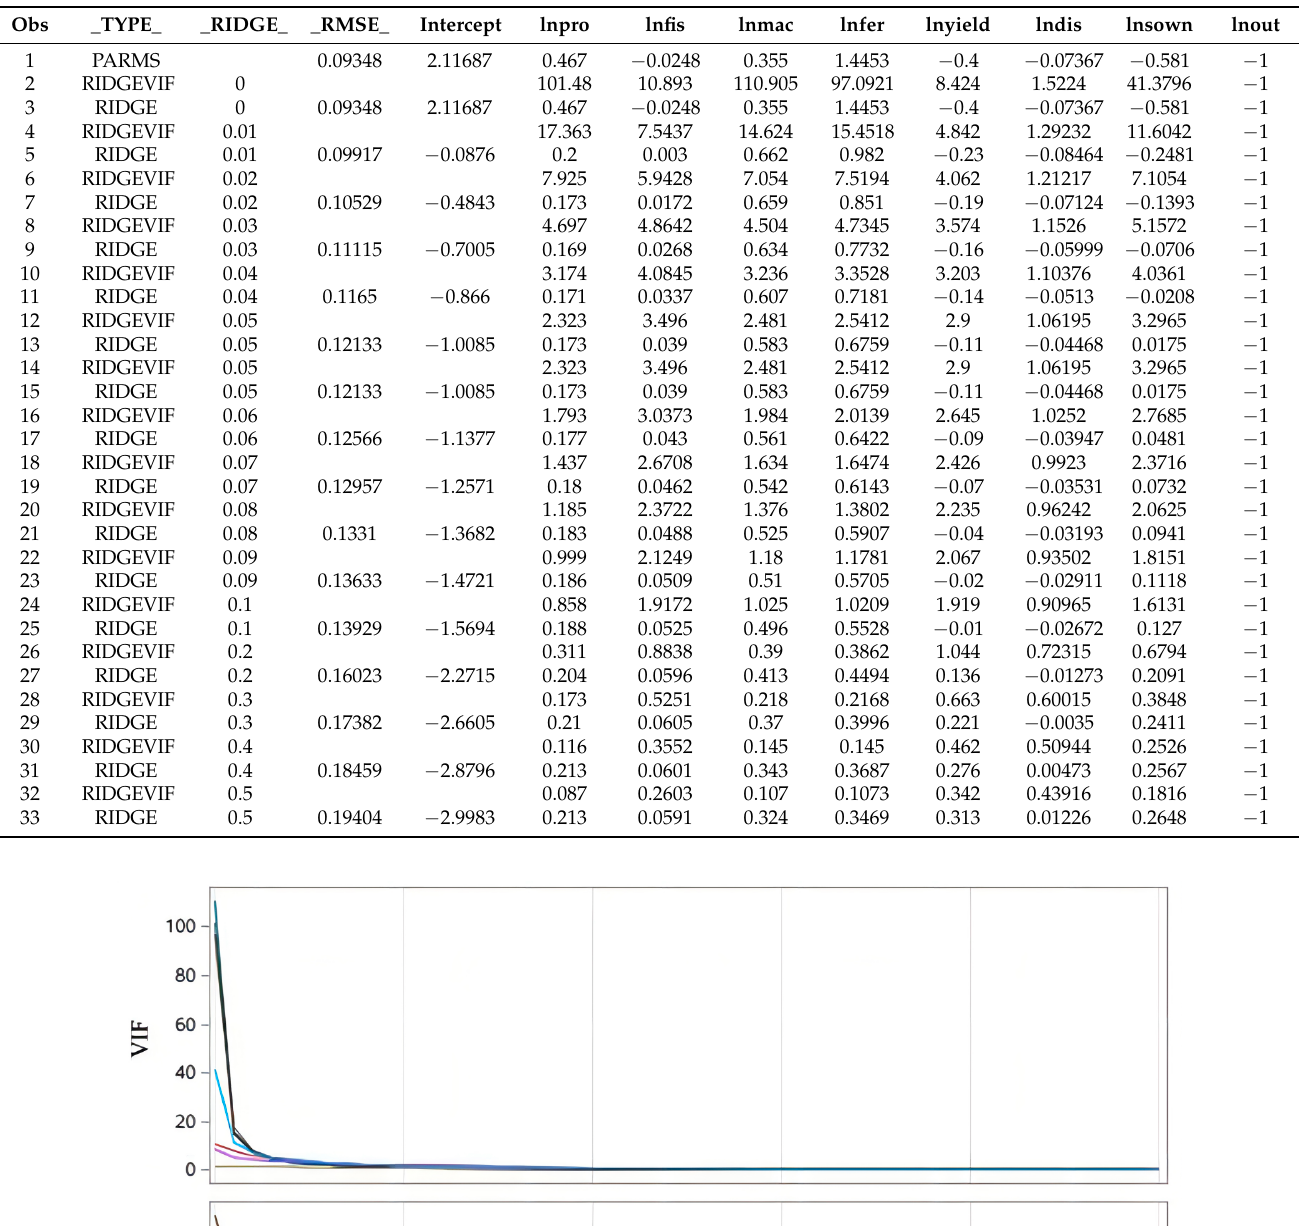
Table 6. The Parameter Estimates for the Ridge Regression.